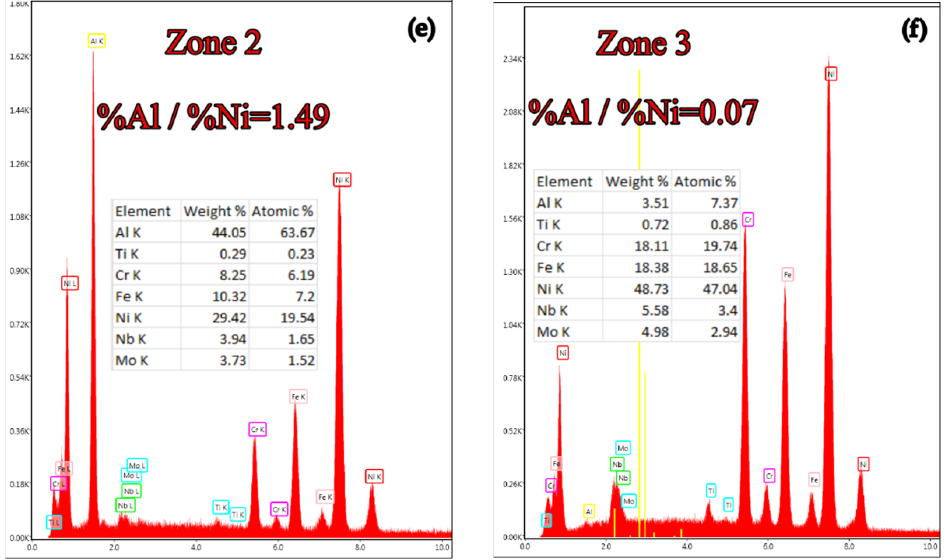
Figure 5. Aluminized IN 718 superalloy (900 °C/5 h), in a pack aluminizing mixture (50 wt.% Al + 49 wt.% Al 2 O 3 +1wt.% NH 4 Cl); SEM-EDS spectra corresponding to the different areas investigated, and the %Al/%Ni ratio in the investigated areas.